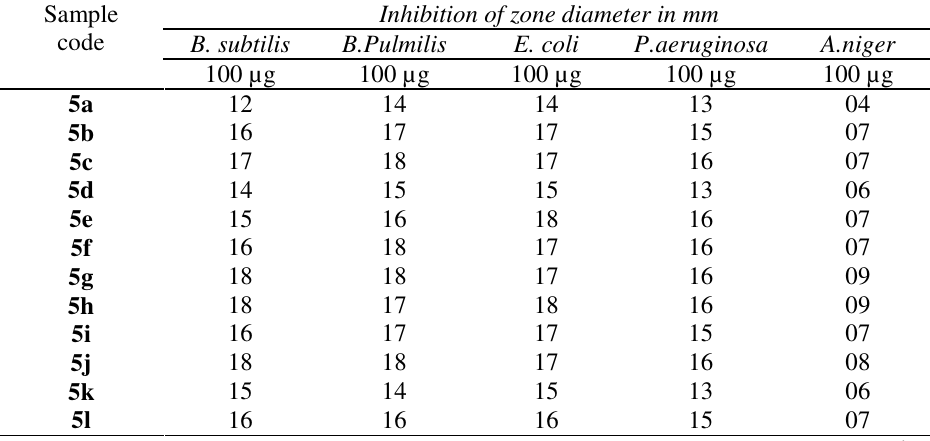
Table 4. Antimicrobial activity of compounds ( 5a-q